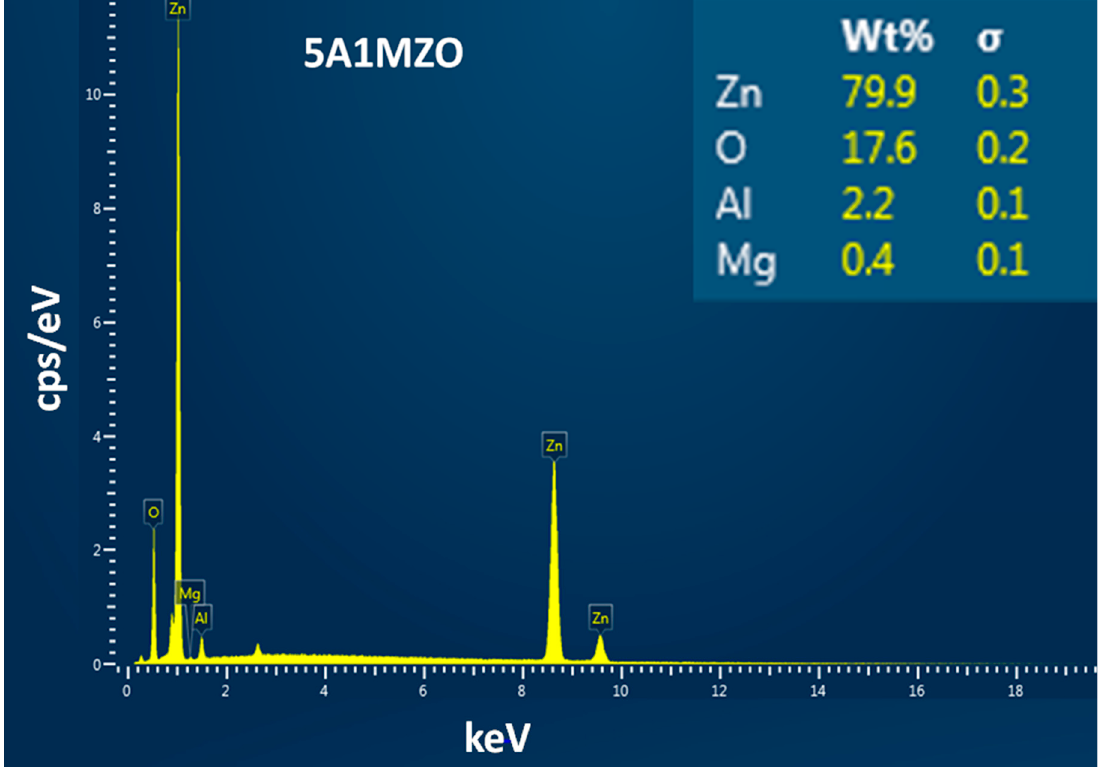
Figure 6. EDX spectrum of 5A1MZO sample.